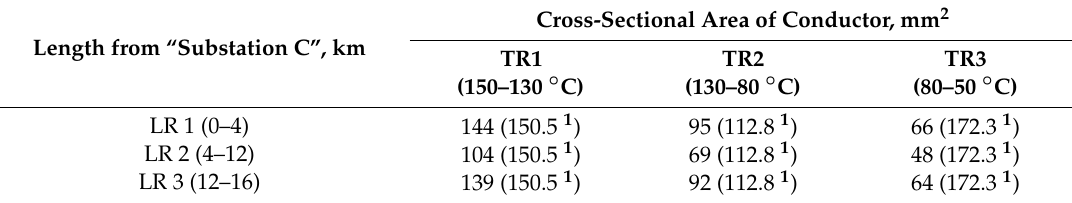
Table 7. Final selection of cross-sectional area of conductor for “OHL